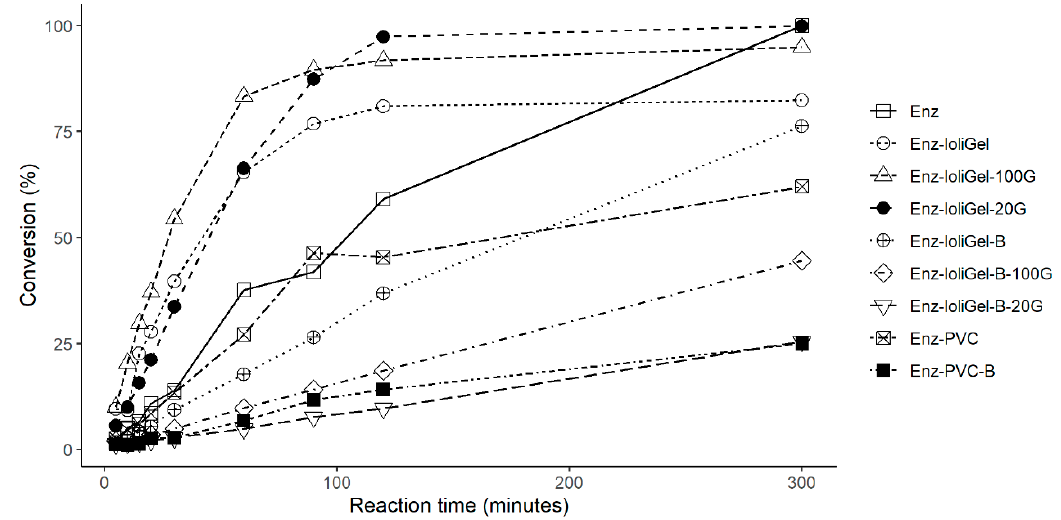
Figure 3. Time course of butyl butyrate synthesis from vinyl butyrate (150 mM) (not depicted) and 1-butanol (not depicted) (150 mM) at 30 °C. The synthesis activity was calculated from the initial slope and the conversion % was calculated at the end of the reaction (300 min).